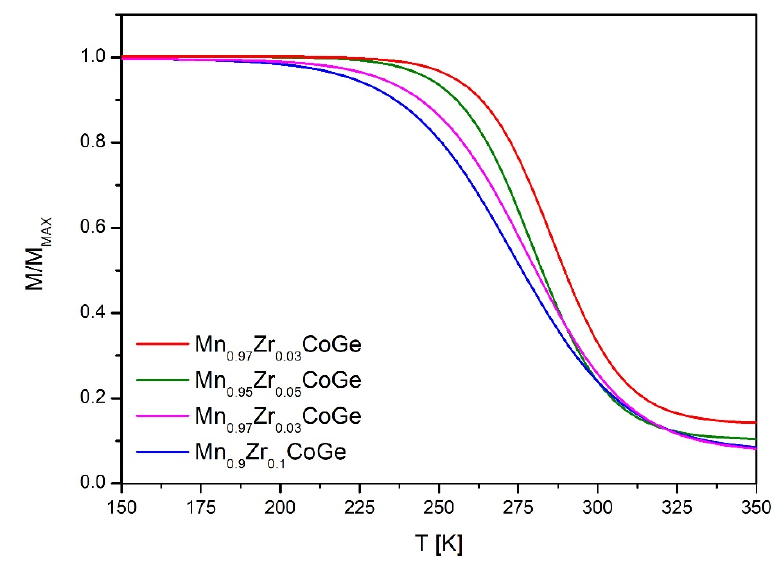
Figure 5. The temperature dependences of magnetization collected under the external magnetic field of 0.01 T for all studied samples. Values were normalized to their maximum value.